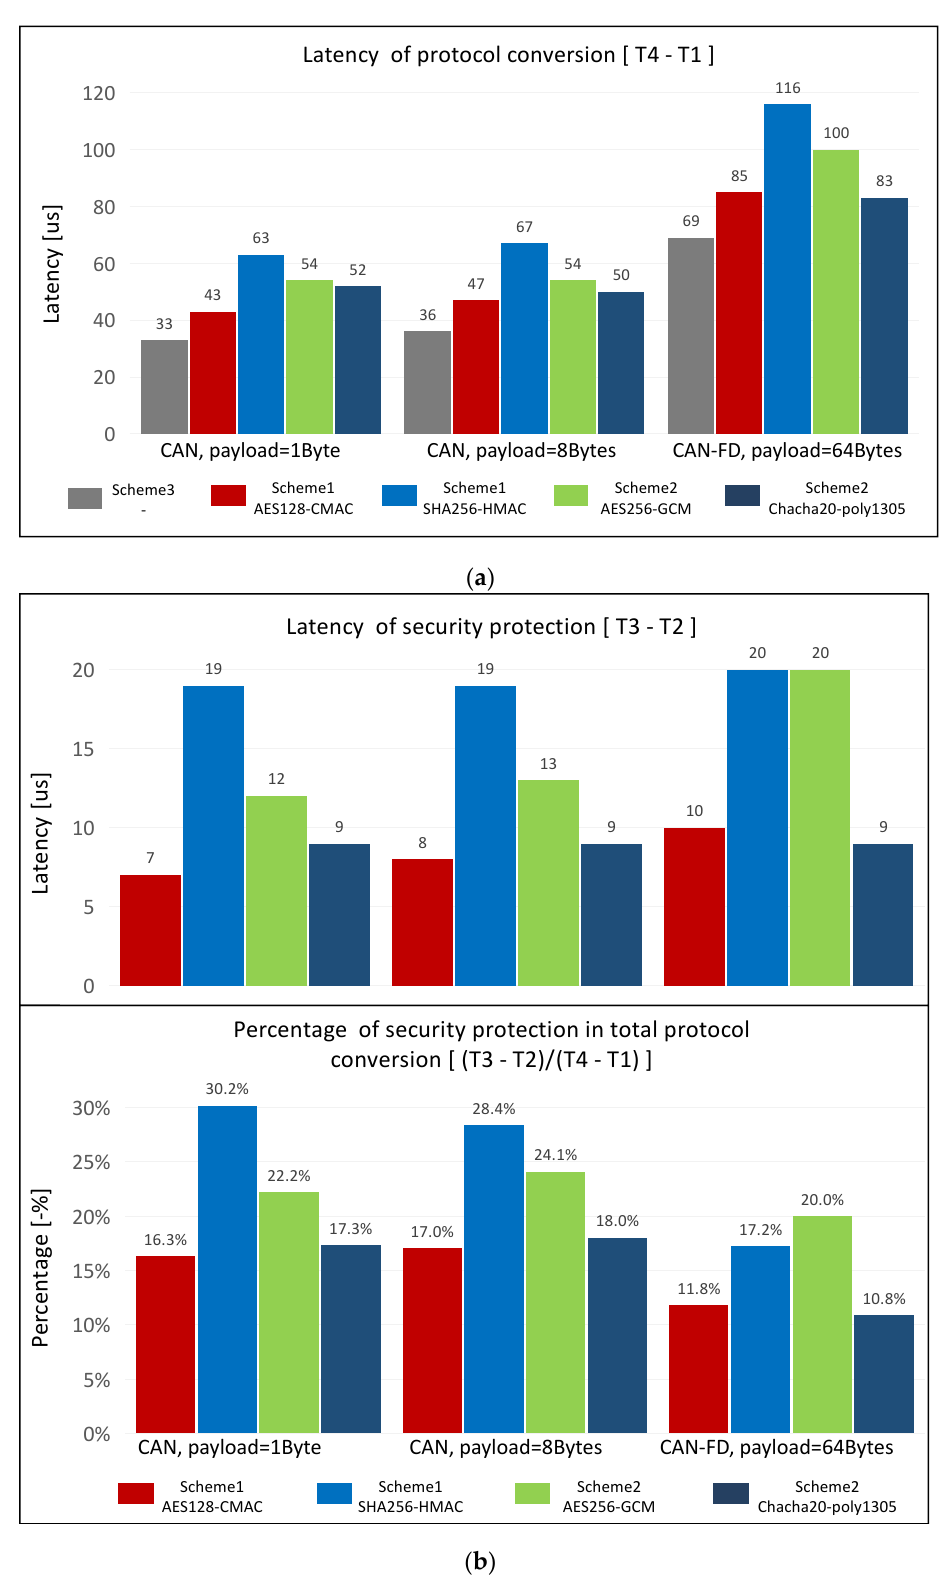
Figure 14. The latency characteristics of the designed gateway: ( a ) latency of the protocol conversion process; ( b ) latency of the security scheme.